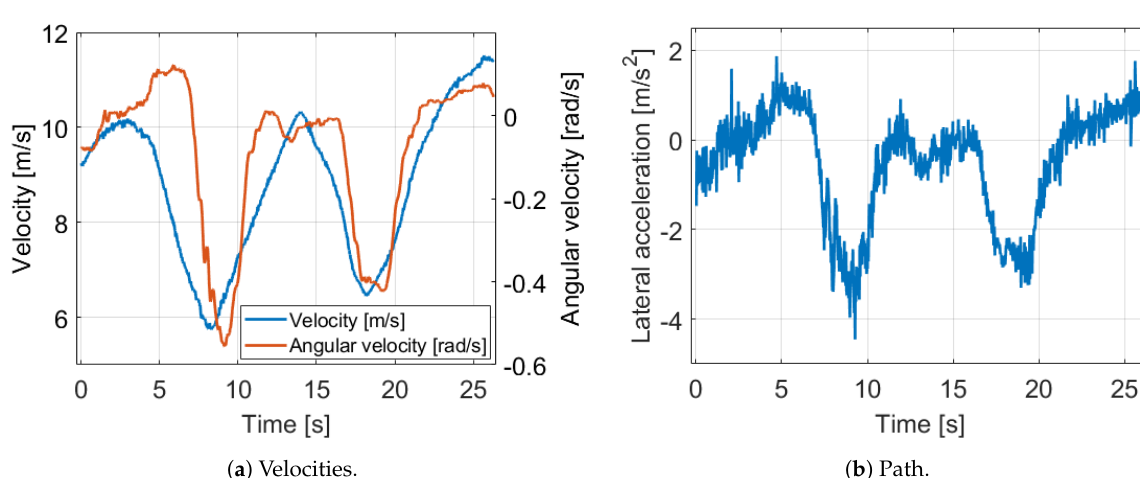
Figure 2. Velocity and acceleration signals of the motivation